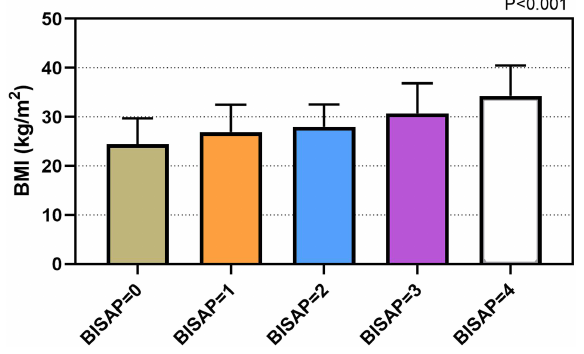
Figure 3. Values of BMI in different groups of BISAP score. The values of BMI were significantly different according to BISAP score system, which increased respectively from BISAP 0 to 4. BMI, body mass index; BISAP, bedside index of severity in acute pancreatitis. Table 2. Relationship Between Obesity and AP-Associated Gastrointestinal Injury